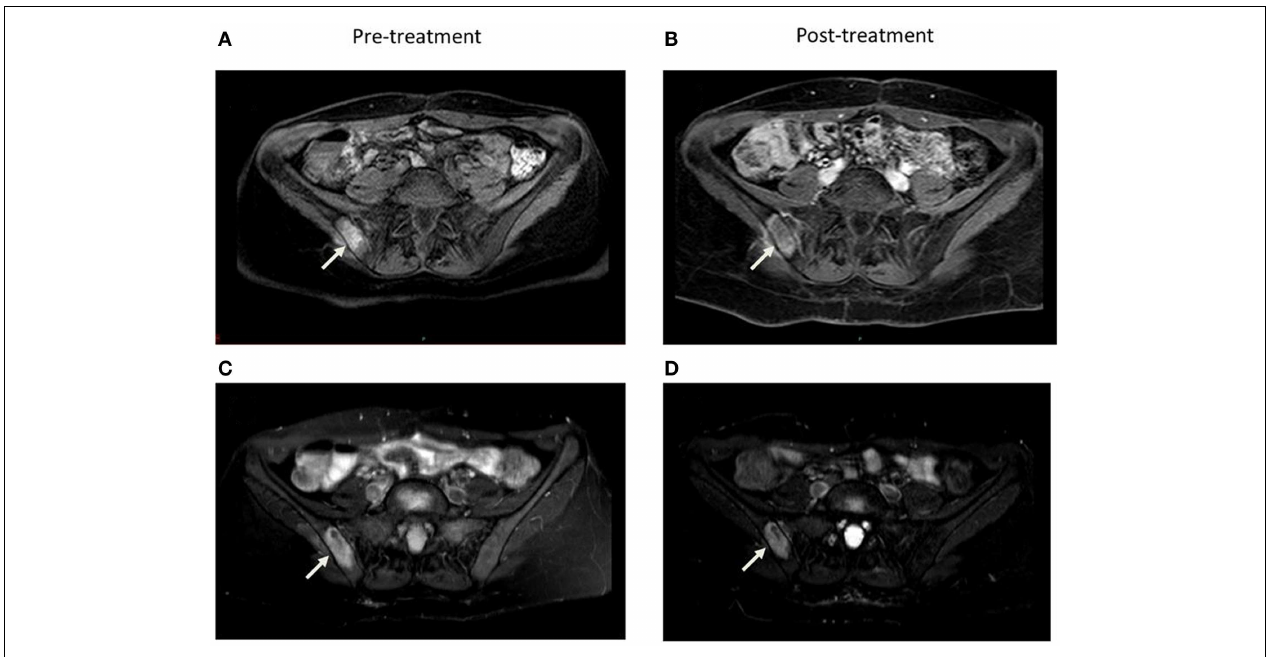
FIGURE 1 | Comparison of axial 1 month pre and 5 months post-treatment contrast enhanced (A, B) and STIR (C, D) MRI images demonstrate decrease in vascularity and size of the right sacroiliac joint